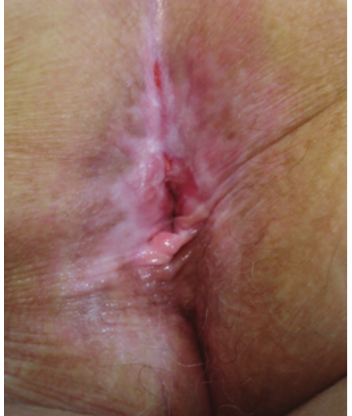
Figure 1: Large cauliflower-like giant condyloma acuminatum on the anogenital area.